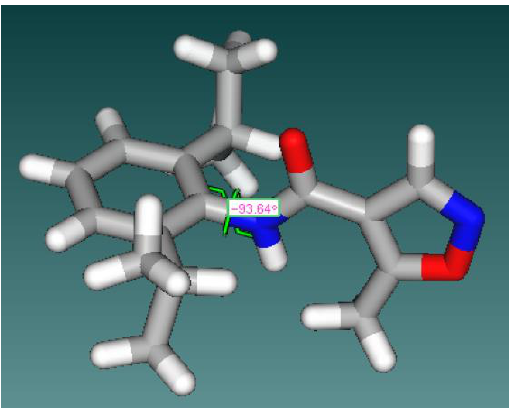
Figure 4. 3D structure of compound 2 , showing the dihedral angle between C=O group and the benzene ring.